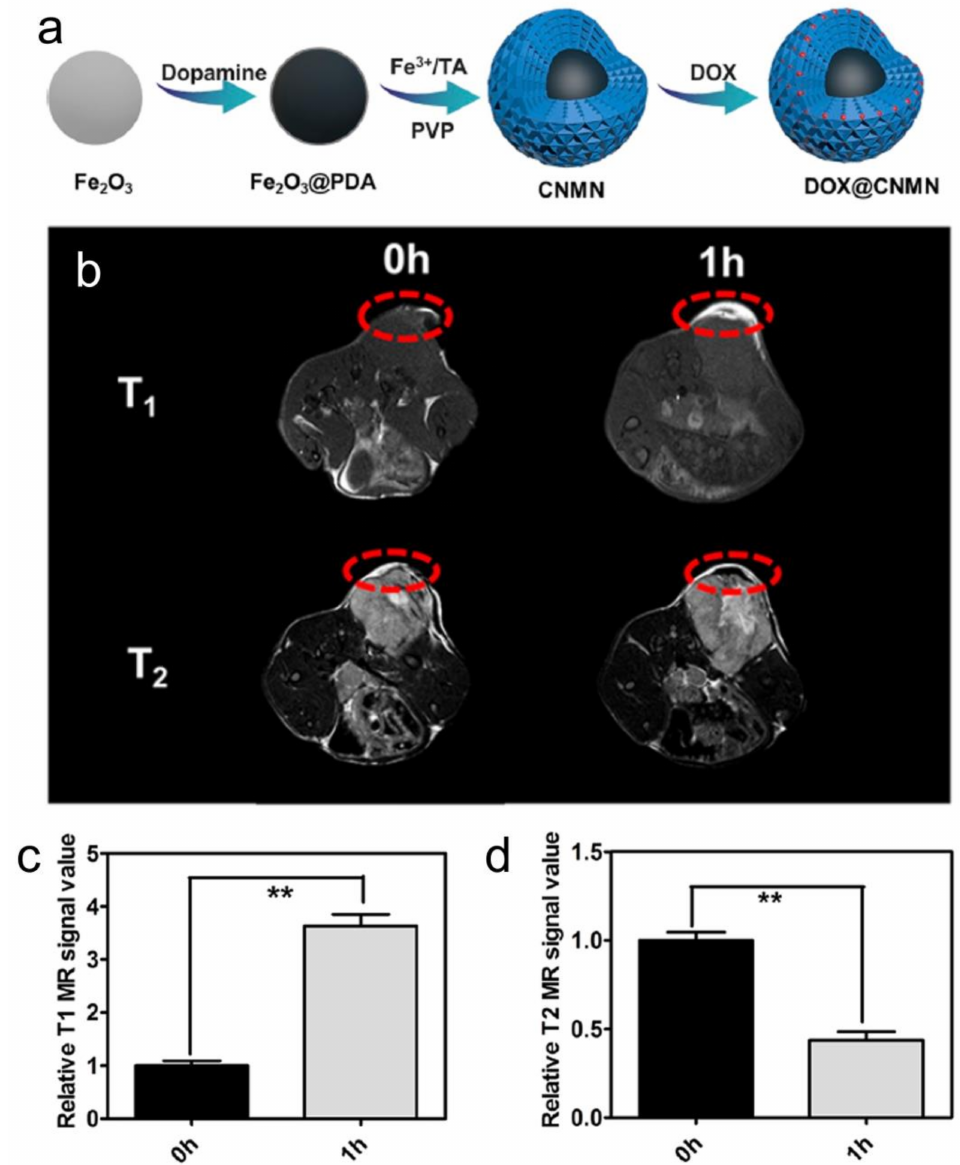
Figure 6. ( a ) Schematic illustration of the preparation of DOX@CNMN; ( b ) T1/T2 MR images of mice; and ( c , d ) the corresponding data analysis after intravenous injection of CNMN nanoparticles at different time intervals. The time of 0 h means pre-injection ( n = 3). ** p < 0.01. Figure adapted from [70]. Copyright 2020 American Chemical